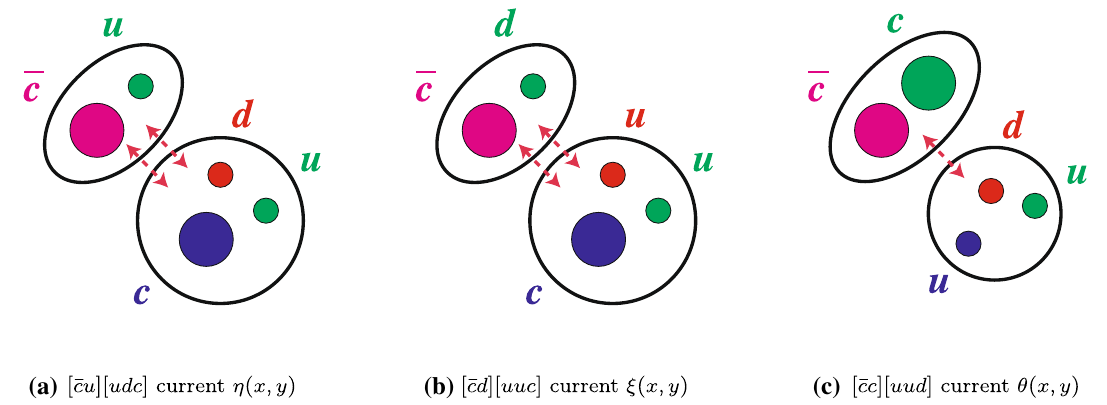
Fig. 1 Three types of hidden-charm pentaquark currents. Quarks are shown in red/green/blue color, and antiquarks are shown in cyan/magenta/yellow